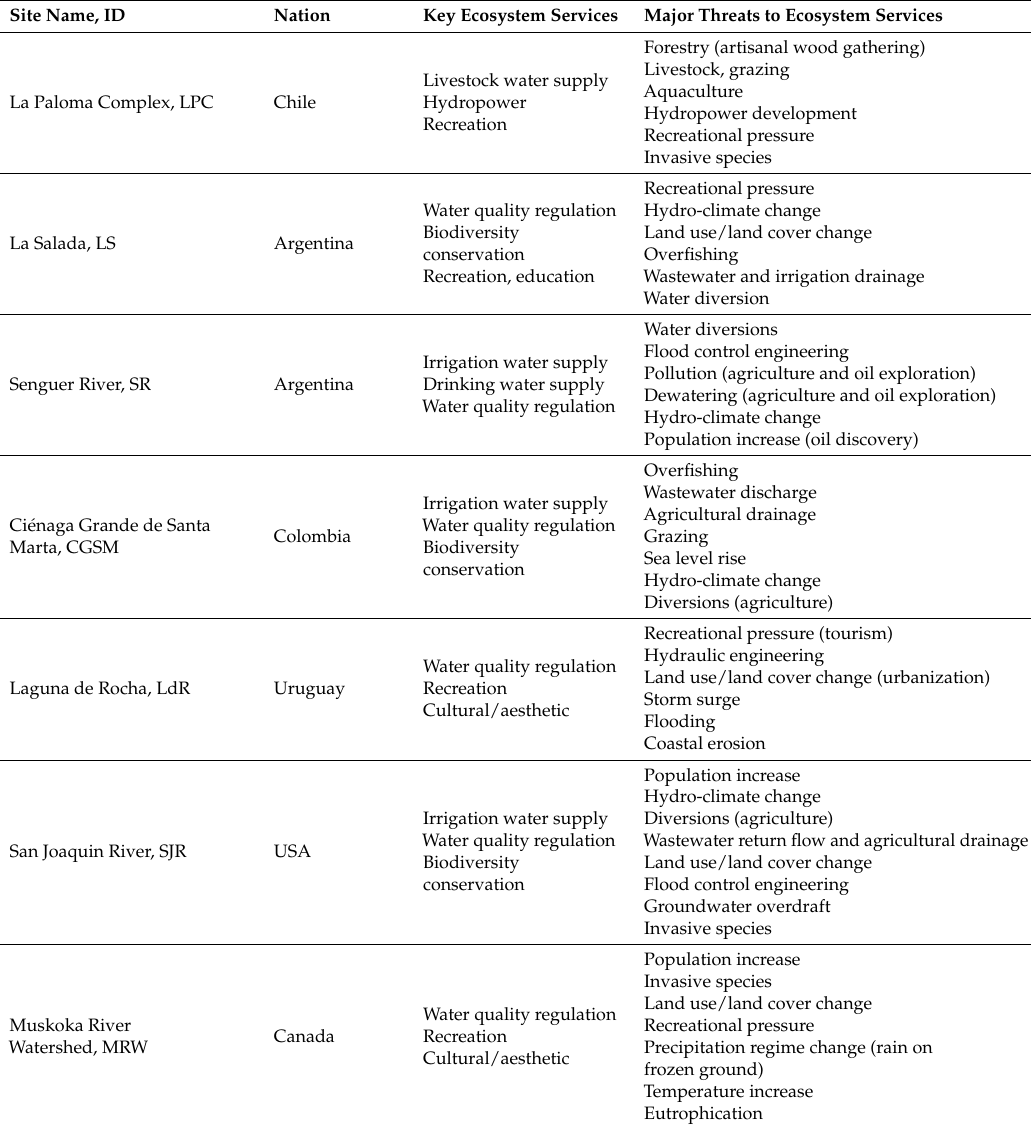
Table 1. Current project (SAFER) study sites, priority freshwater ecosystem services, and major threats. Site Name,